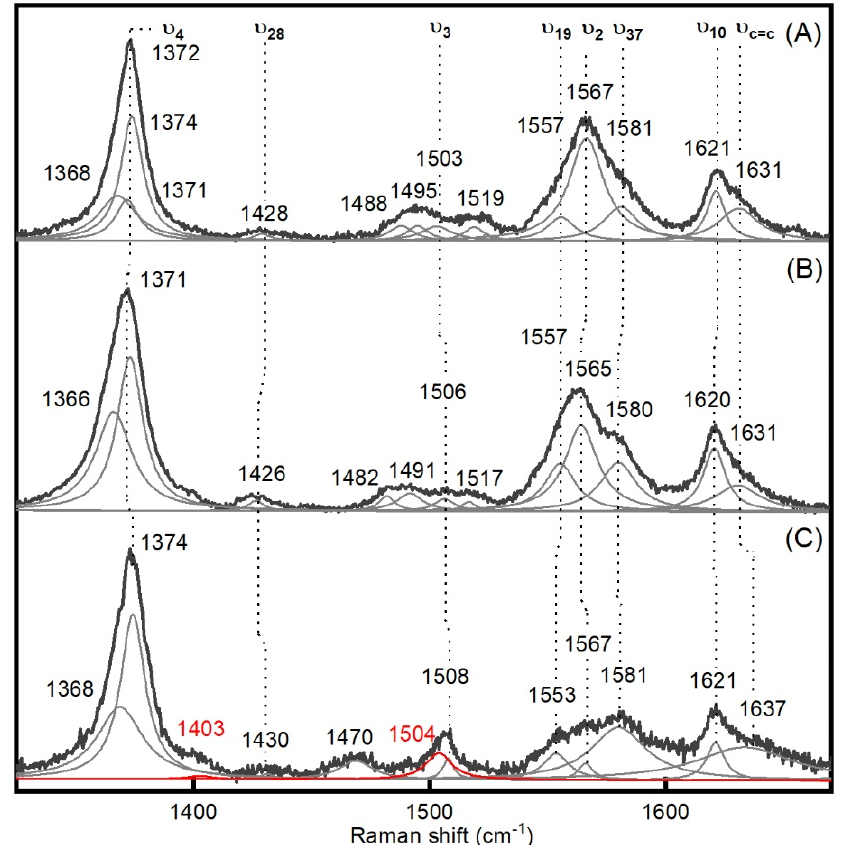
Figure 3. RR spectra of PpDyP recorded with Soret band excitation at pH 7.6 and 298 k under aerobic conditions. ( A ) Resting enzyme, measured at open circuit potential. ( B ) Compound I, measured at − 0.190 V applied potential. ( C ) Compound II, obtained after addition of ferricyanide to the product of aerobic electrolysis at − 0.190 V shown in panel ( B ). Black lines are experimental spectra. Gray lines are the result of spectral deconvolution and correspond to Lorentzian RR bands of the heme. Bands and labels in red are assigned to tyrosyl radical stretchings.